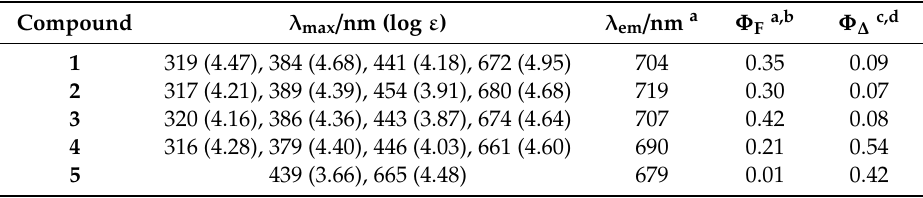
Table 1. Electronic absorption and basic photophysical data for 1 – 5 in N , N -dimethylformamide (DMF). Compound λ max / nm (log ε